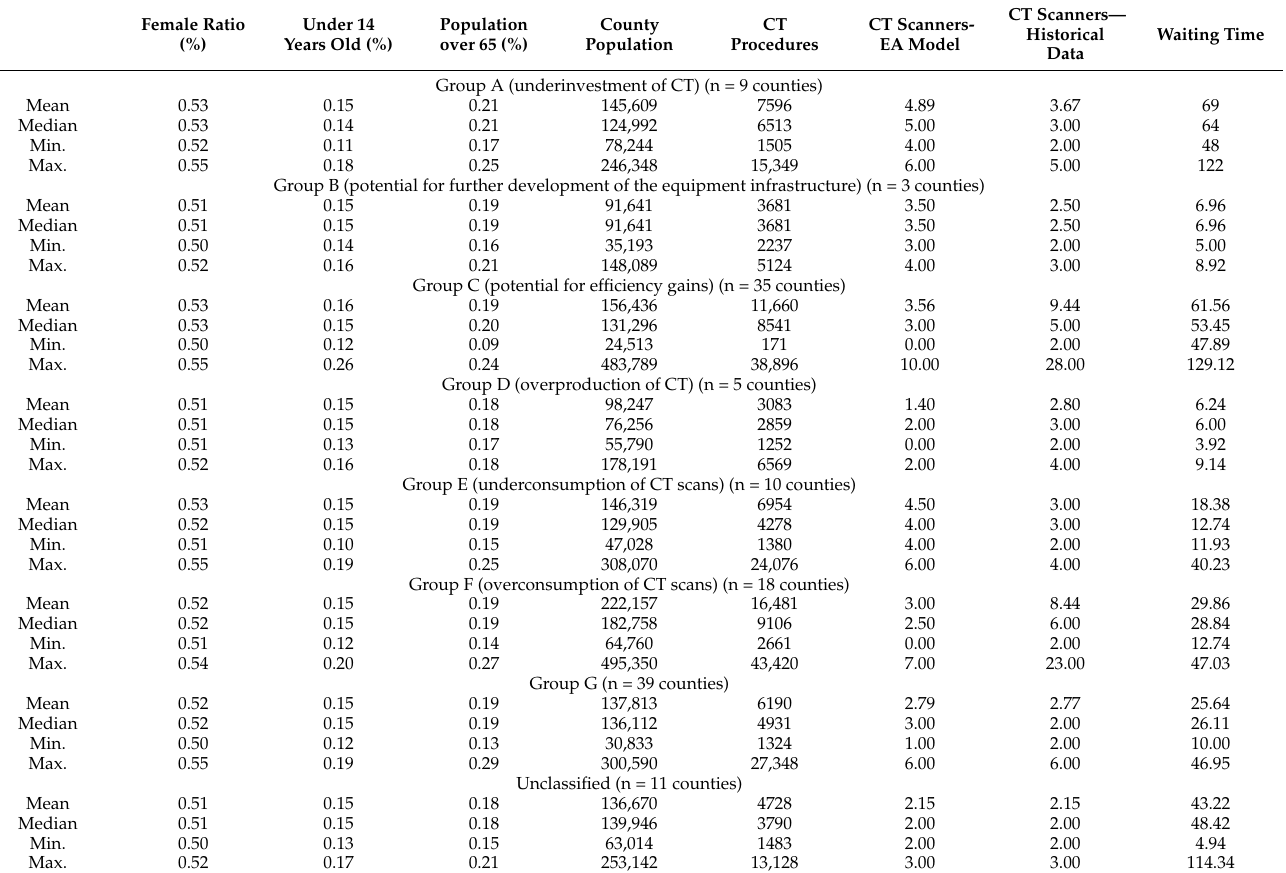
Table 3. Descriptive characteristic of the studied Polish counties grouped into one of the seven categories based on the difference between the historical number of CT scanners in a given county and the results of the EA model and compared with historical average CT waiting times